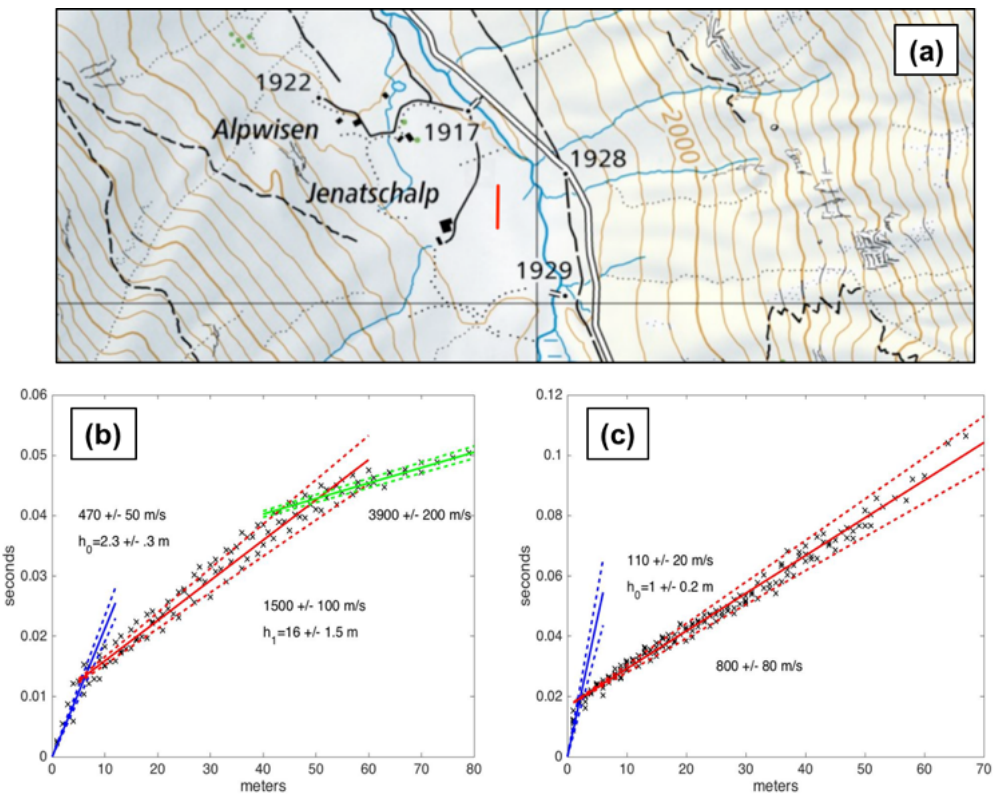
Figure 10. (a) Location map of the geophysical investigations in the Jenatschalp site (red profile), reproduced with permission from Swis- stopo (JA100118). (b) Results of the active seismic refraction for P-wave velocity ( V p ) layering (b) and S-wave velocity ( V s ) layering (c) . Table 1. Numerical ground model deduced from geophysical investigations. These parameters are used in order to model d V/V values, and they are assumed constant before and after snowfall